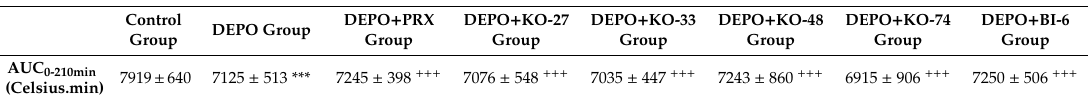
Table 3. Values of AUC from 0 to 210 min for core temperature. Each group consisted of eight rats. Data are represented by mean ± S.E.M. at each time after injection. Diethyl-paraoxon (DEPO) vs. Control: *** p < 0.001. Diethyl-paraoxon (DEPO) + oximes vs. Control: +++ p <